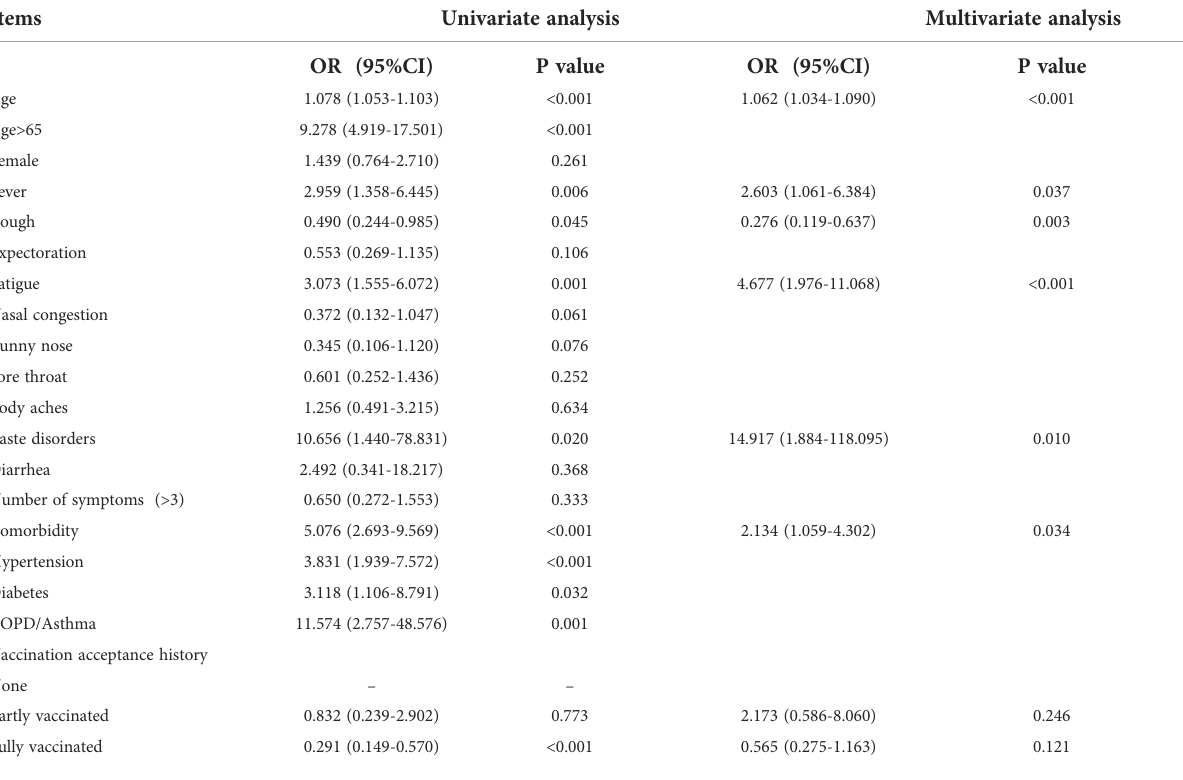
TABLE 3 Univariate and multivariate logistic regression analysis of risk factors for non-severe to severe COVID-19 (including death).